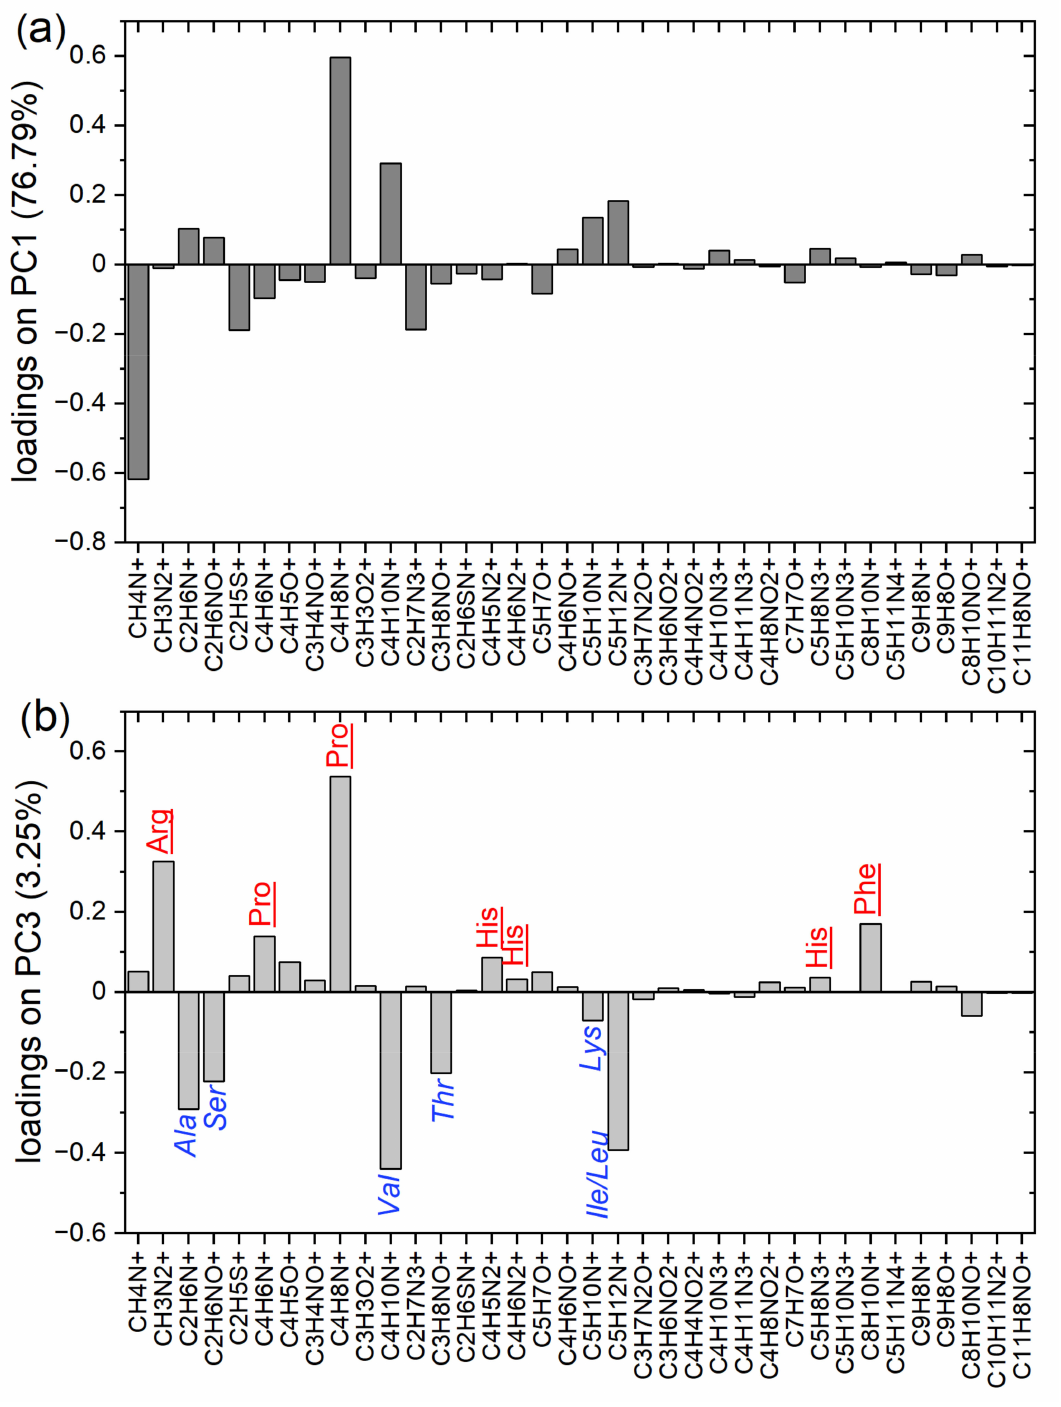
Figure 3. Loadings plots for the principal components presented in Figure 2. ( a ) Loadings plot for PC1. ( b ) Loadings plot for PC3: amino acid ion fragments abundant in the Fc domain (red underlined) load in the positive direction, while amino acid fragments with higher content in the F(ab) 2 domain (blue italic) load in the negative